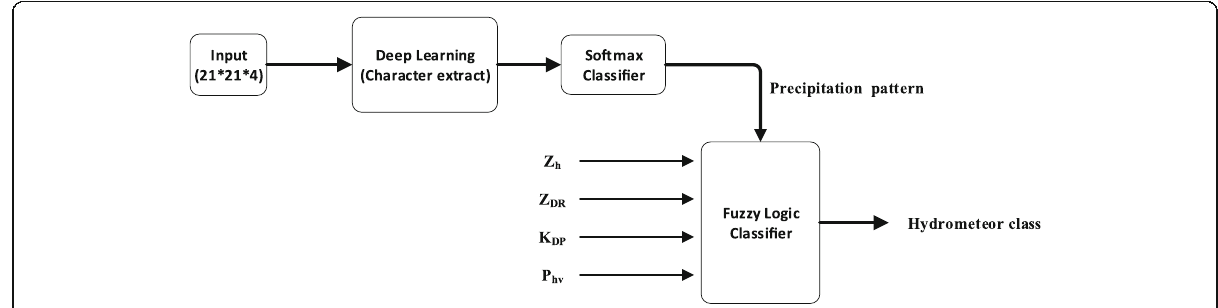
Fig. 2 Overview of the hydrometeor-type identification